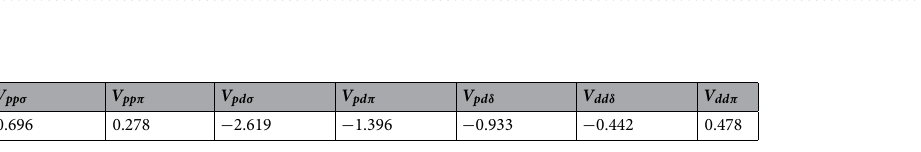
Table 2. Slater-Koster tight binding parameters in Eqs. (5–7) for monolayer MoS 2 . All terms are in units of eV.